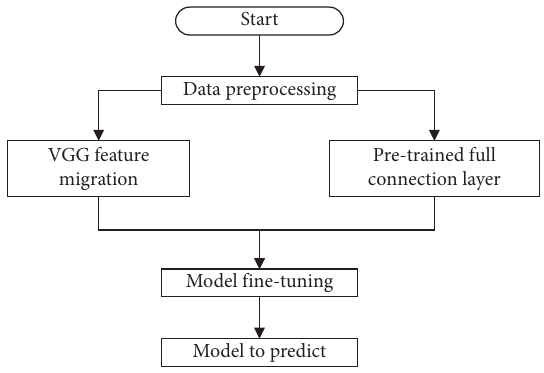
Figure 2: The model flowchart of transfer